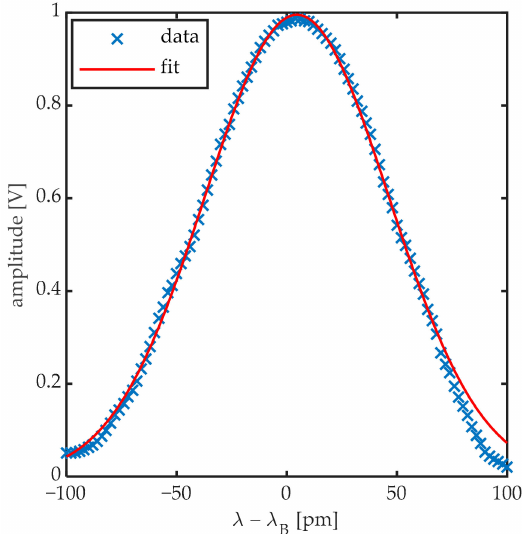
Figure 10. Locations on the spectrum of the 8-mm FBG where the laser was locked for performing UGW measurements at t = 0, together with the Gaussian fit used to extract the Bragg peak’s